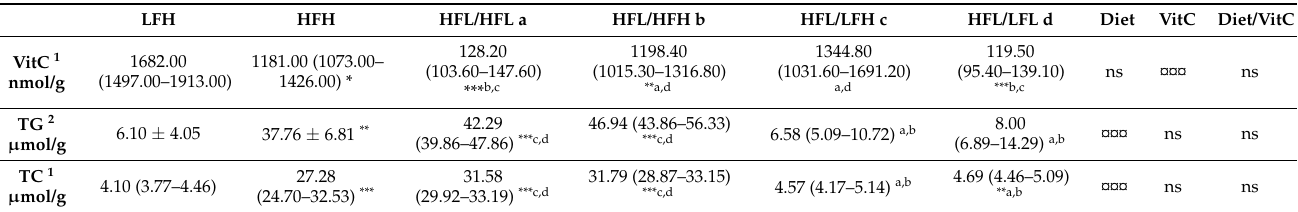
Table 3. Liver levels of measured markers following 32 weeks on